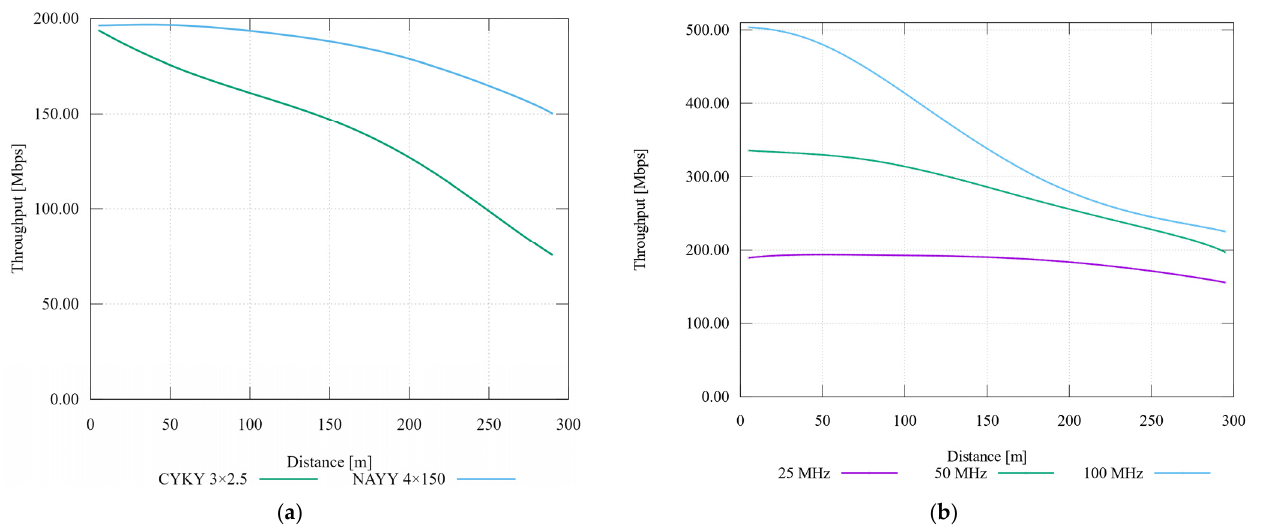
Figure 9. ( a ) Comparison of throughput with cable type sweep; ( b ) Comparison of throughput with bandwidth